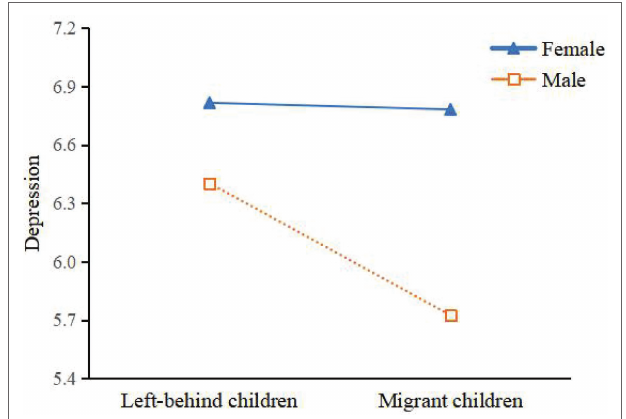
FIGURE 1 | Gender difference as moderator of the relationship between internal migration and children’s depression.